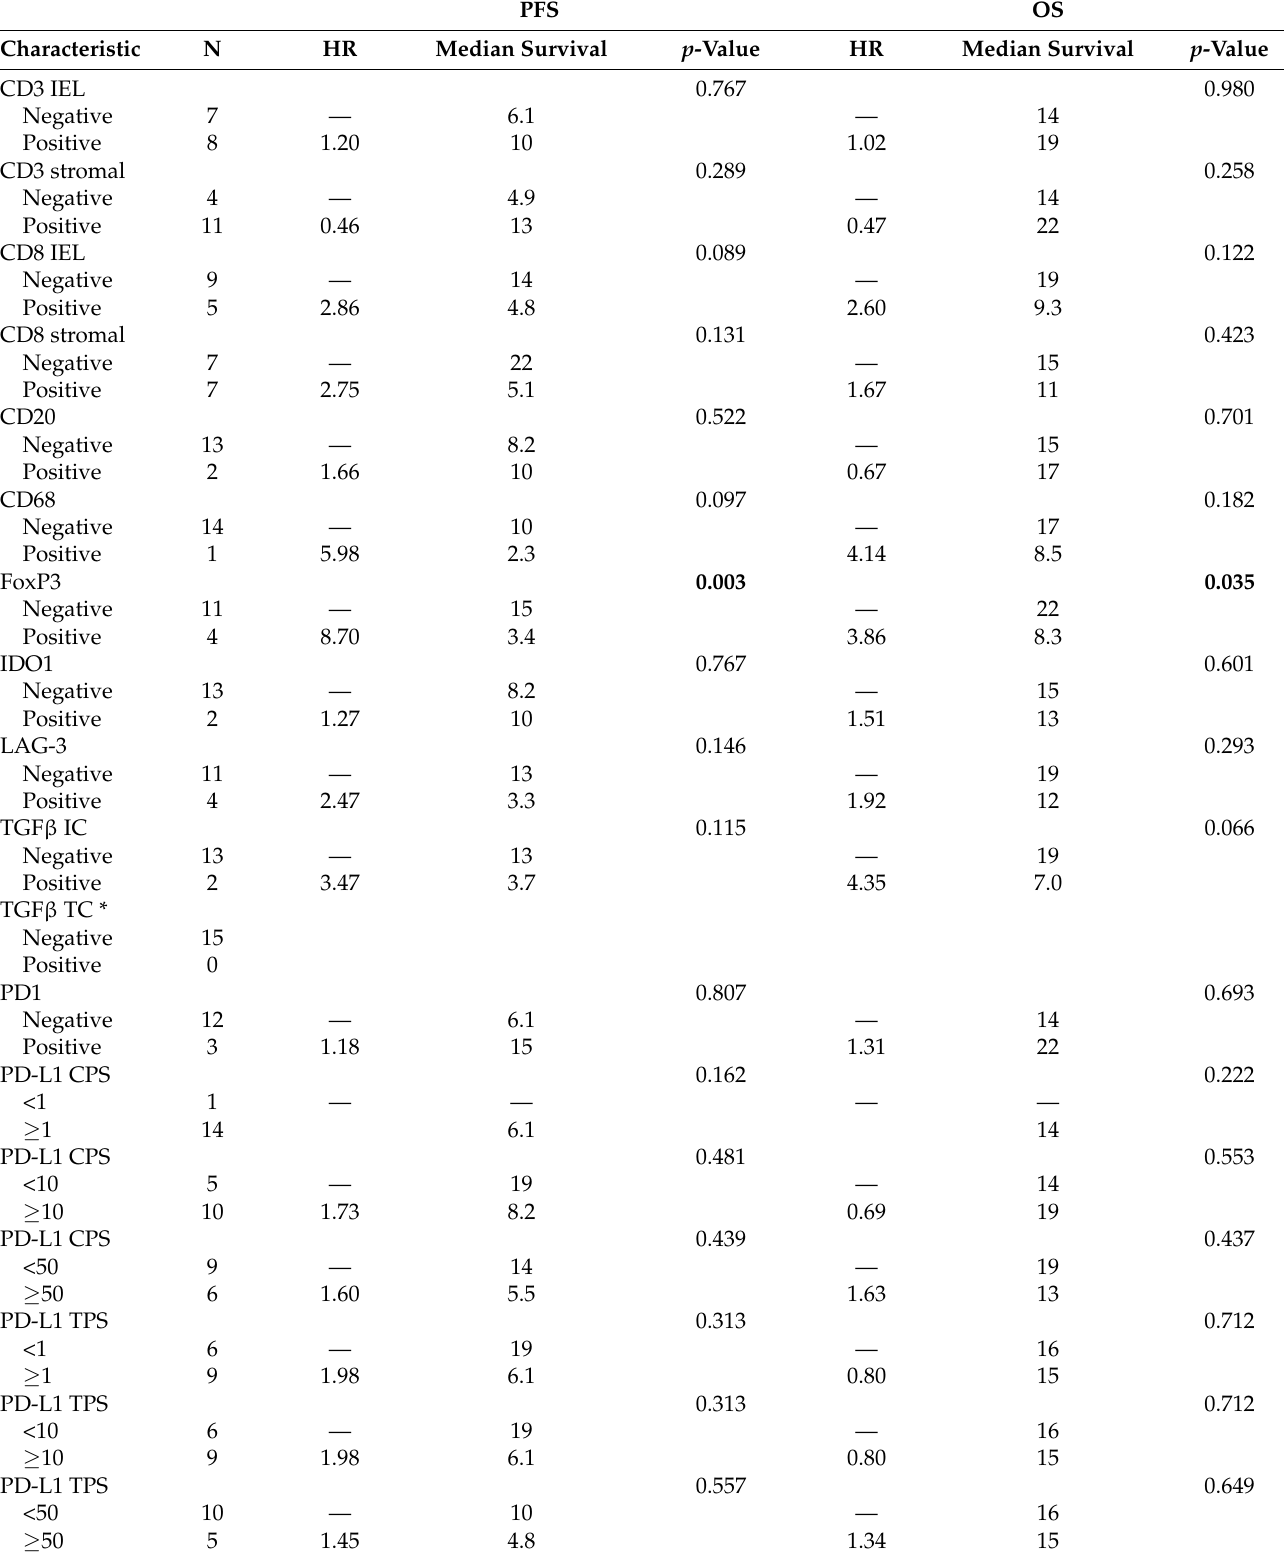
Table 4. Association of assessed IHC markers with survival parameters in the NSCLC